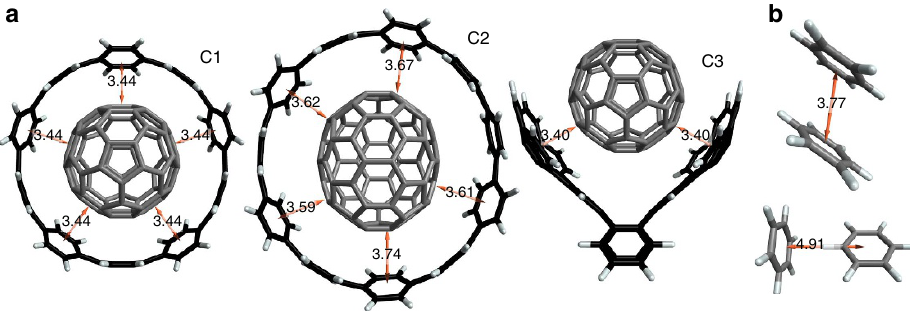
Figure 1 | Equilibrium structures of studied p (cid:2) p stacked complexes. Marked distances are in ångstro¨ms. Geometries of all structures are available as XYZ files in Supplementary Data 1. ( a ) Three supramolecular complexes comprising the fullerene C70 molecule (grey) as a guest in three different hosts (black and white): [10]-and [11]CPP, and a buckycatcher molecule, labelled C1, C2 and C3, respectively. ( b ) Benzene dimer in its two nearly degenerate conformations: stacked parallel-displaced (top) and T-shaped